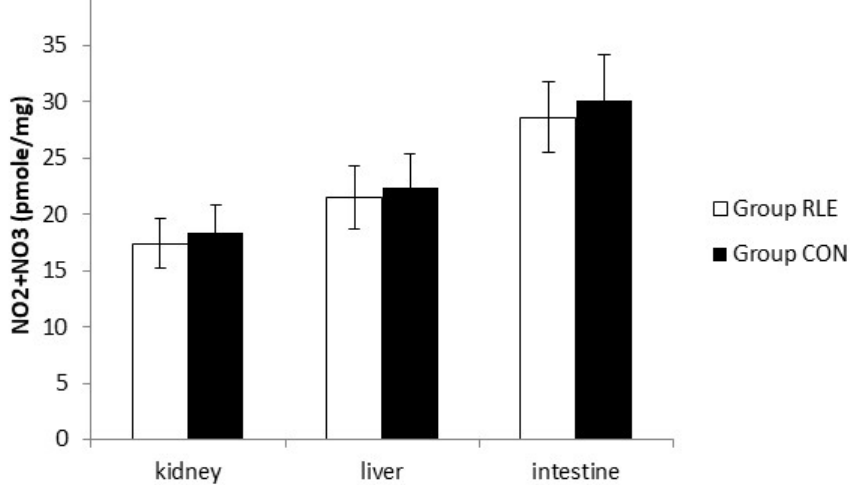
Figure 3. Effect of red orange and lemon extract (RLE) on nitric oxide (NO) production from kidney, liver, and intestine cell at the end of treatment measured by Griess reagent. Group RLE (RLE treated group); Group CON (control). Data are expressed as mean ± standard deviation (SD).